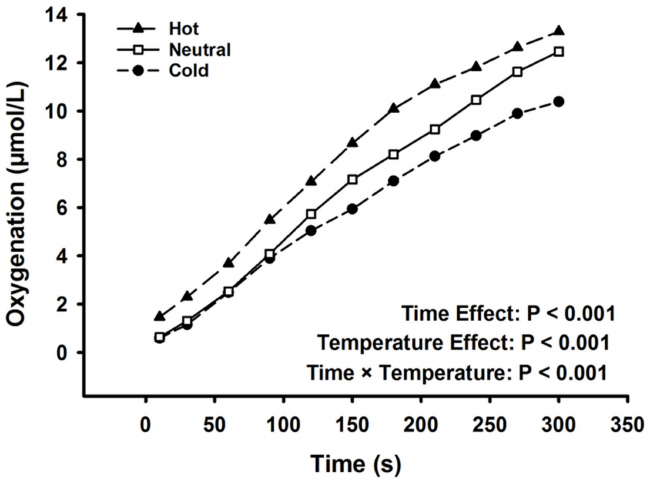
Figure 3. Prefrontal cortex oxygenation, as calculated as change from baseline values, throughout the fatiguing task. There was a main e ff ect of time, temperature condition, and an interaction ( p < 0.001). Data are displayed as mean values. Standard deviation bars were removed for